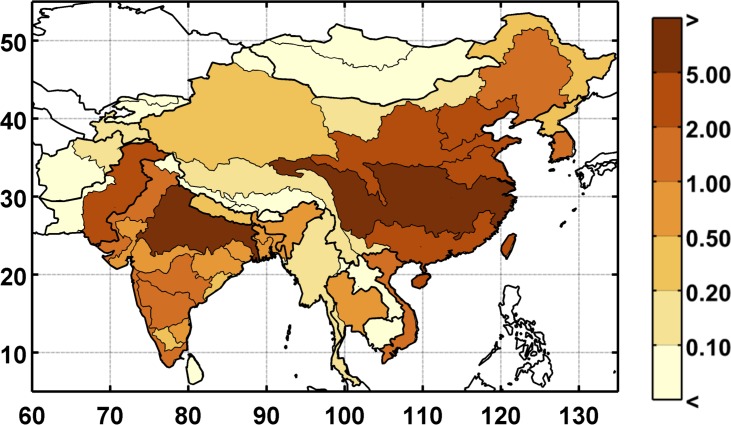
Baseline domestic water requirement (in billion cubic meters).